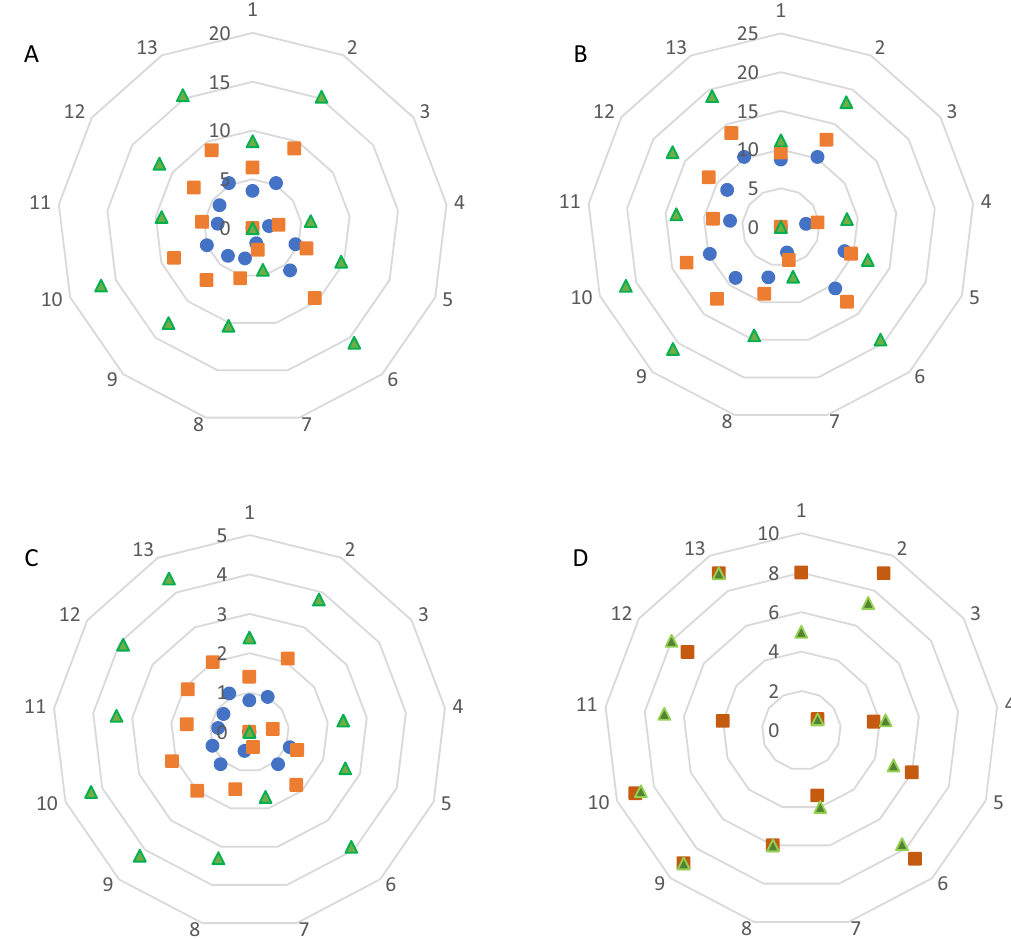
Figure 3. The effect of horticulture media on cucumber plant parameters during vegetation. ( A ) Plant height (cm), ( B ) leaf lateral span (cm), ( C ) leaf number, ( D ) plant conditions (grade). Filled blue circle: one weeks. Filled orange square: two weeks. Filled green triangle: three weeks. 1-WC, 2-WC:SM, 3-WN, 4-WN:SM, 5-WPG, 6-WPG:SM, 7 WPGN, 8-WPGN:SM, 9-WPGN + WC(1), 10- WPGN + WC(1):SM, 11- WPGN + WC(2), 12-WPGN + WC(2):SM,